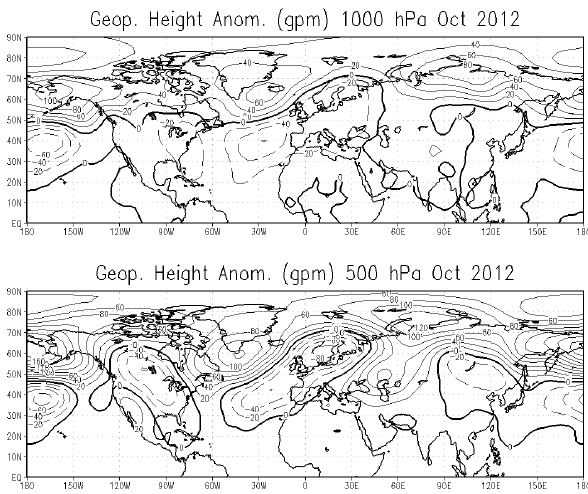
Fig. 5. As Fig. 1 but for October Figure 5. As Figure 1 but for October 2012